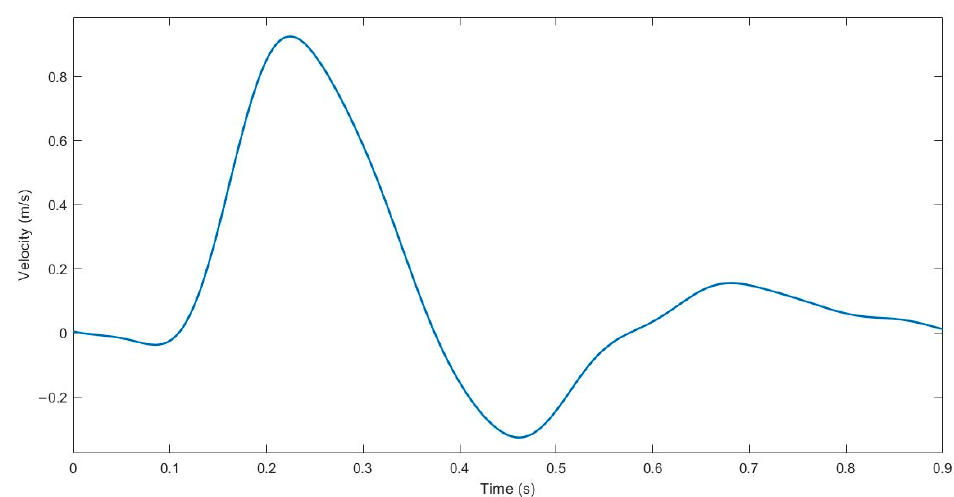
Figure 4. Pulsatile velocity waveform of the femoral artery for transient CFD analysis.